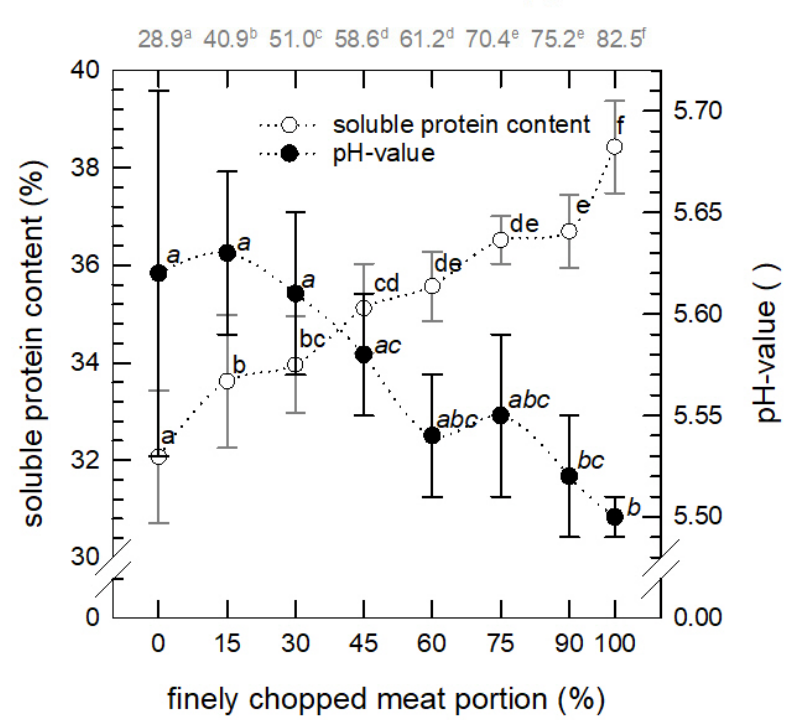
Figure 4. Soluble protein content (white) ( n = 9) and pH value (black) ( n = 9) of raw minced meat with finely chopped meat added (mean ± standard deviation), respectively. For comparability, amount of non-intact cells is illustrated on top of graph. Different letters indicate significant differences ( p < 0.05) for each parameter (pH value in italic).